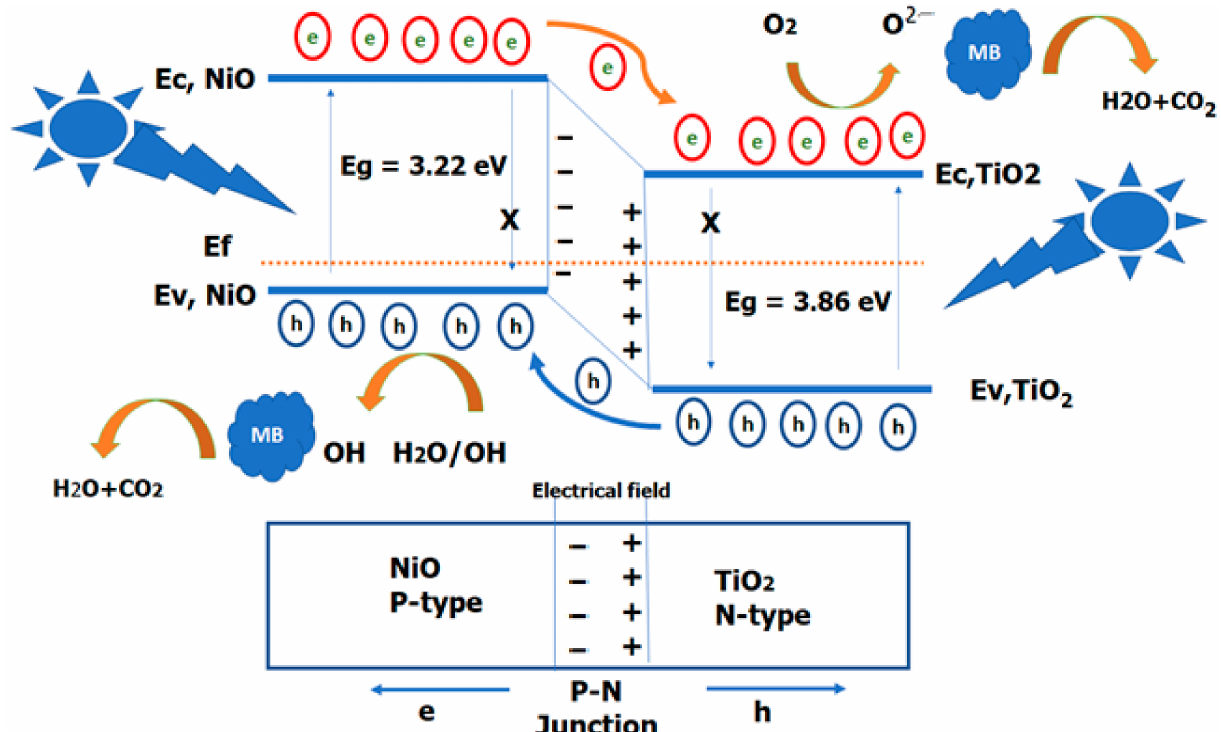
Figure 9. Schematic diagram of the charge transfer in TiO 2 /NiO-based photocatalyst. A schematic energy band diagram of the n-TiO 2 /p-NiO heterojunction structure is plotted in Figure 9. For n-type TiO 2 NTs, the Fermi energy level is closer to the conduction band, while for p-type NiO NTs, the Fermi energy level is closer to the valence band [91]. TiO 2 NTs and NiO NPs couple a nanoscale p-n heterostructure of TiO 2 /NiO is